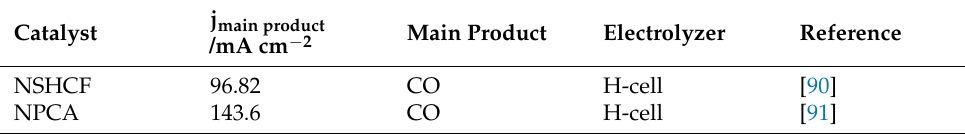
Table 5. Table 5. CO 2 electroreduction performances of metal-free carbon